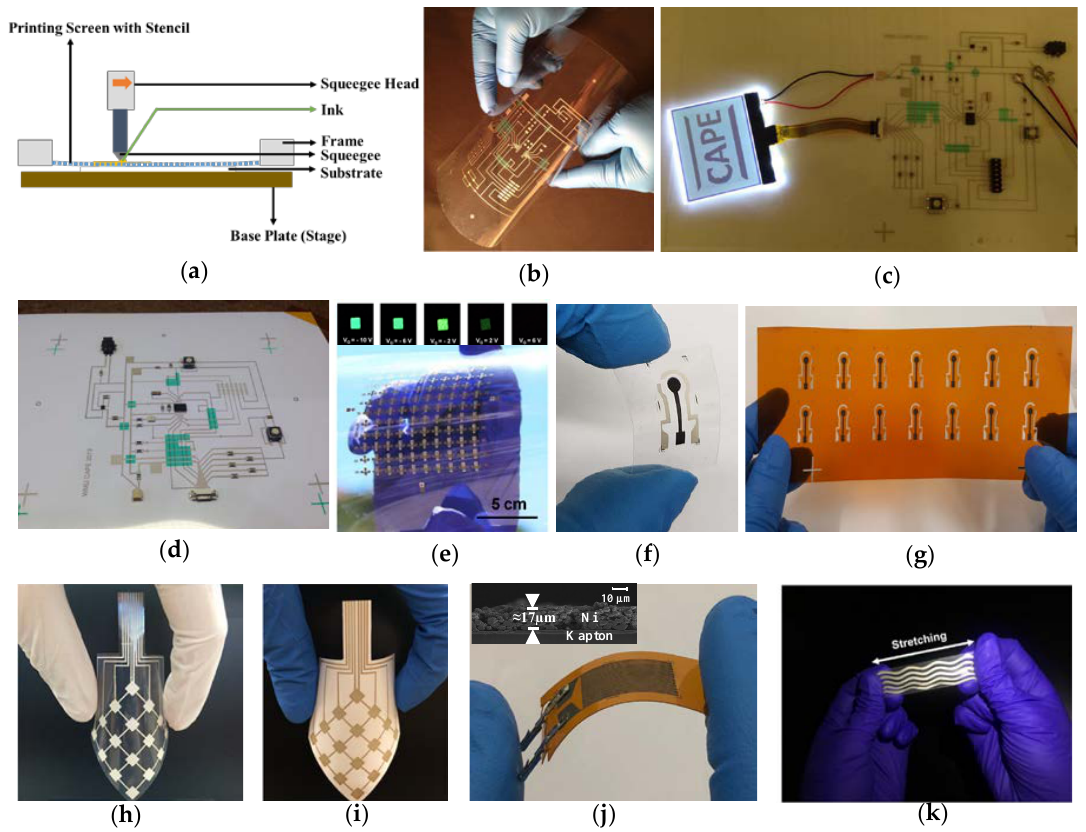
Figure2. ( a )Schematicofscreenprintingprocess; screenprintedmultilayeredflexiblecircuitson( b )poly (ethylene terephthalate) (PET), ( c ) glass, ( d ) paper platforms [93], © IEEE, Reprinted with permission from IEEE Transactions on Components, Packaging and Manufacturing Technology; ( e ) screen printed top-gated TFTs, Reprinted with permission from [94], © American Chemical Society; ( f , g ) flexible and planar electrochemical sensors on PET and PI substrates (2 × 1 cm 2 ) [98,99], Reprinted with permission from RSC and IEEE Sensors Journal; ( h ), and ( i ) polyvinylidene fluoride (PVDF)-based touch sensor on PET and paper platforms, Reprinted from [100] with permission from Elsevier; ( j ) Ni-based resistance temperature detector (RTD) on polyimide substrate (2.5 × 1.2 cm 2 ) [101], © IEEE, Reprinted with permission from IEEE Access; ( k ) flexible and stretchable strain sensors, Reprinted from [102] with permission from